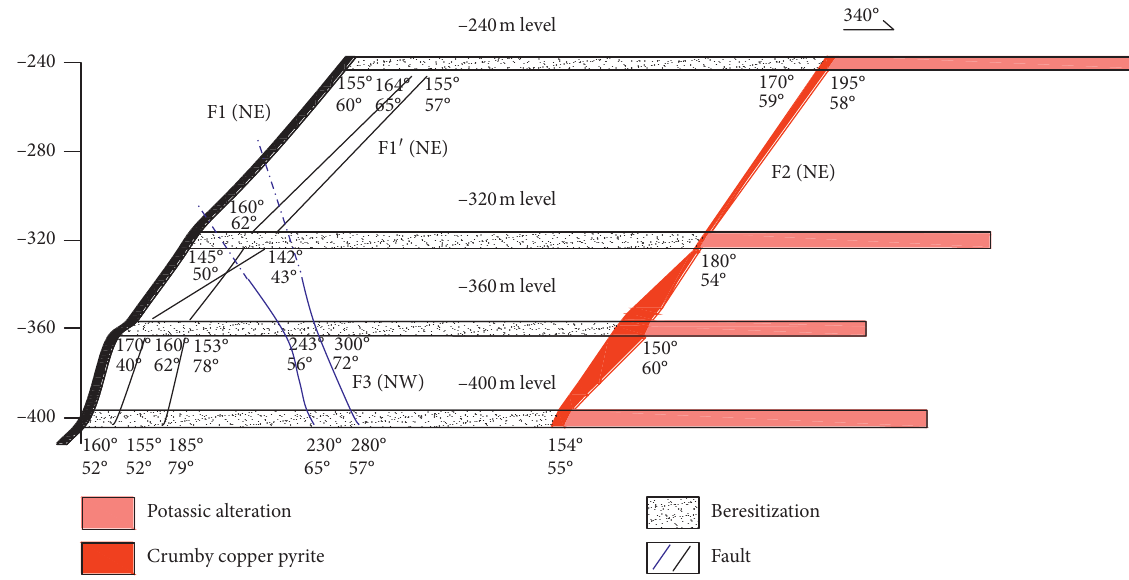
Figure 2: The multiple faults distribution of the geological cross section in SW orebody of Xinli mine.